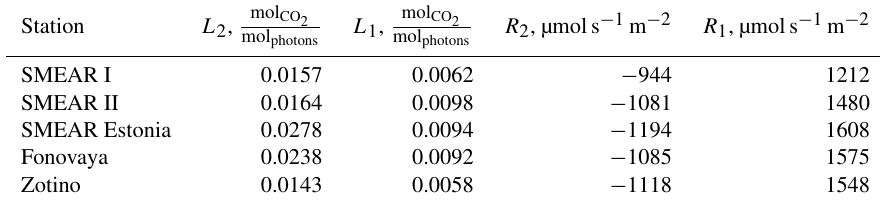
Table 4. Linear regression coefficients for PAR and LUE at different sites: LUE = L 1 + L 2 · (R d /R g ) , PAR = R 1 + R 2 · (R d /R g )